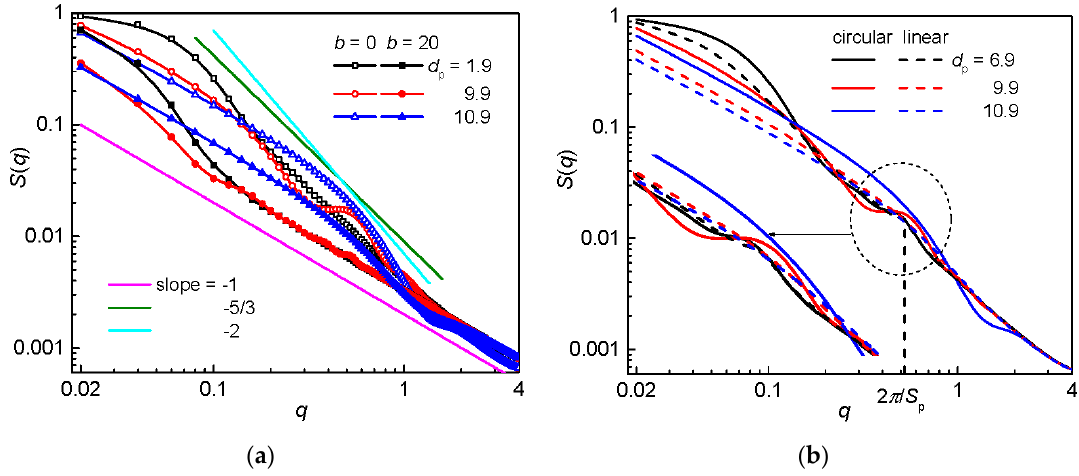
Figure 8. Structure factor for: a flexible and semiflexible circular chain ( a ); and for a flexible circular and linear chain ( b ) confined in an array of nanoposts of fixed post separation S p = 12 and various post diameters d p . In ( a ), the solid lines represent the characteristic slopes that might be expected for a biaxially confined chain; and, in ( b ), the inset zooms in the region of humps with the vertical dashed line indicating its predicted onset.